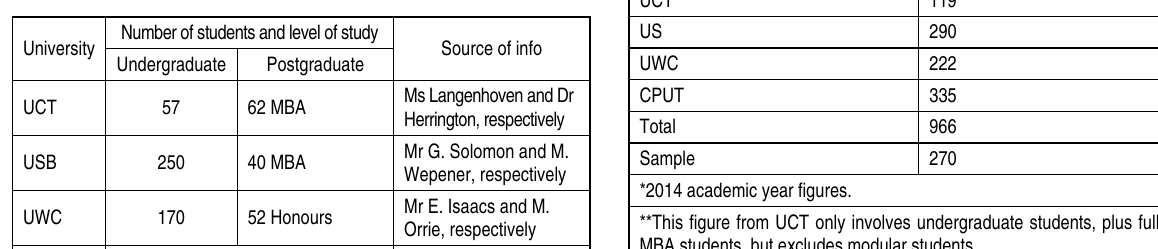
Table 1. Determination of the population